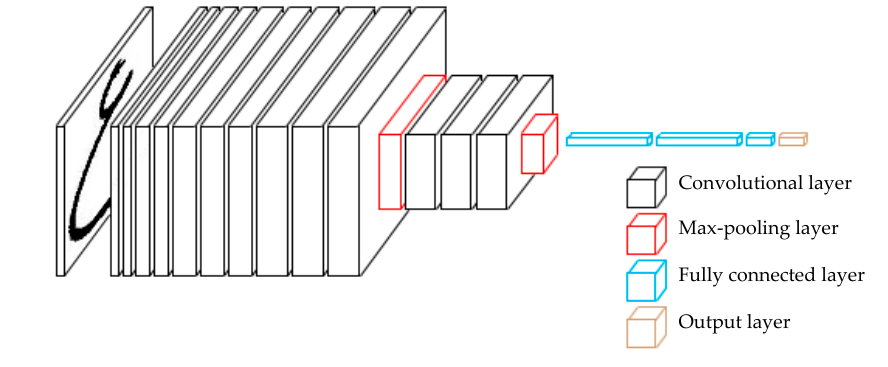
Figure 3. The Architecture of alphanumeric VGG. Table 2. Number of parameters.